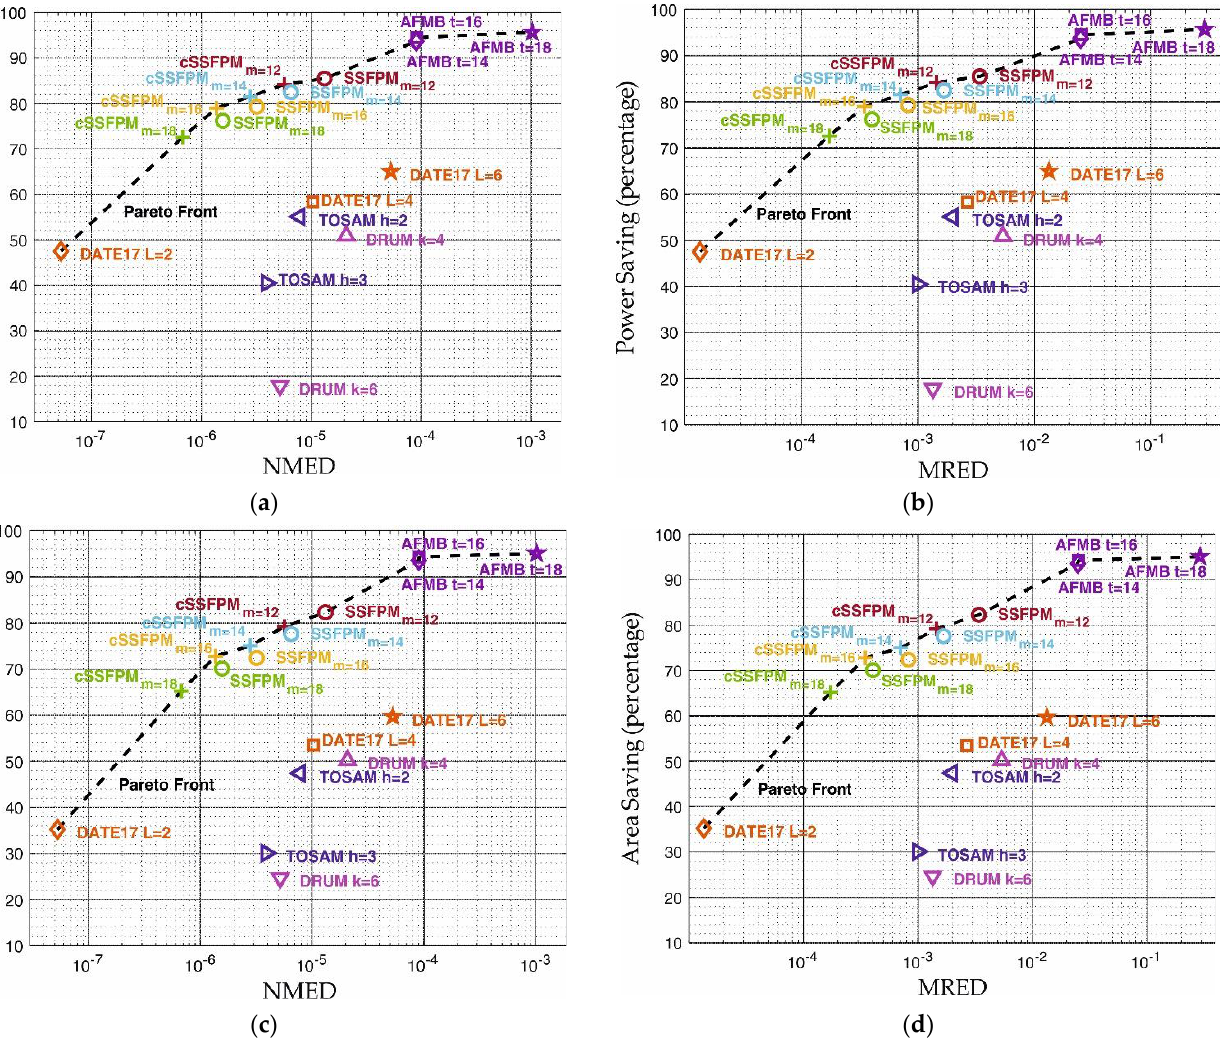
Figure 12. Power saving versus ( a ) NMED and ( b ) MRED , and area saving versus ( c ) NMED and ( d ) MRED .